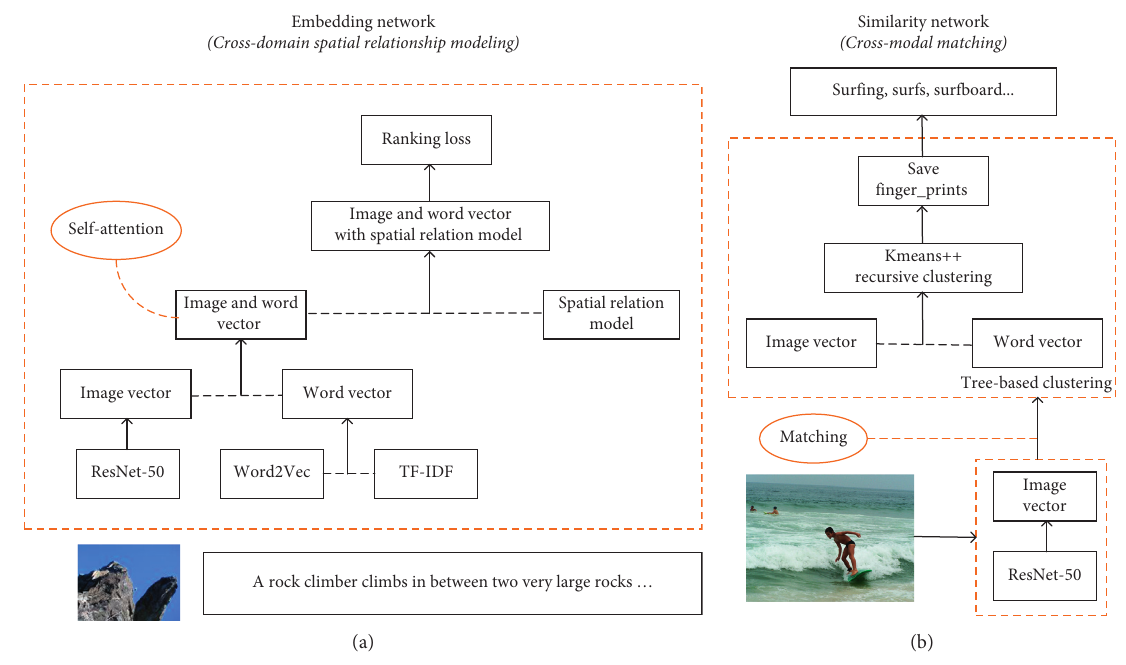
Figure 1: The cross-modal reasoning framework. (a) Embedding network. (b) Similarity